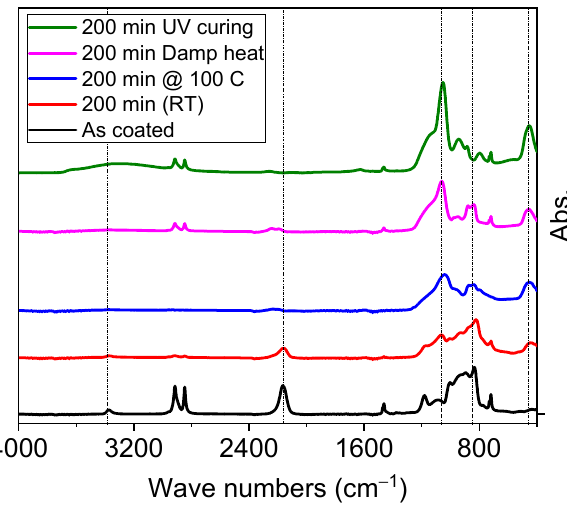
Figure 1. FTIR spectra of PHPS cured with different methods.